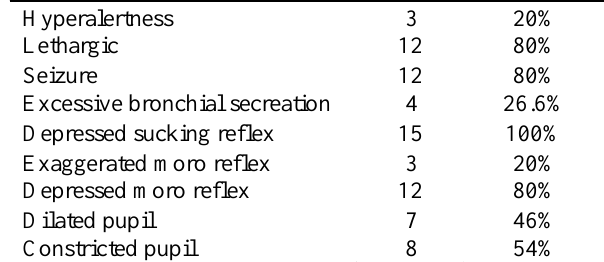
Table I: Clinical presentation of the cases of HIE (N= 15) Hyperalertness